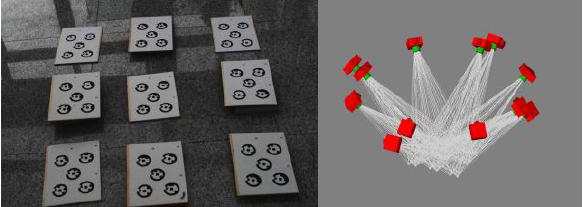
Figure 3. Examples of coded targets to be adopted for camera calibration and their spatial layout (left). Typical geometry of a block of convergent images used for camera calibration (right). The block should also include at least a couple of images taken with the camera rolled from landscape to portrait